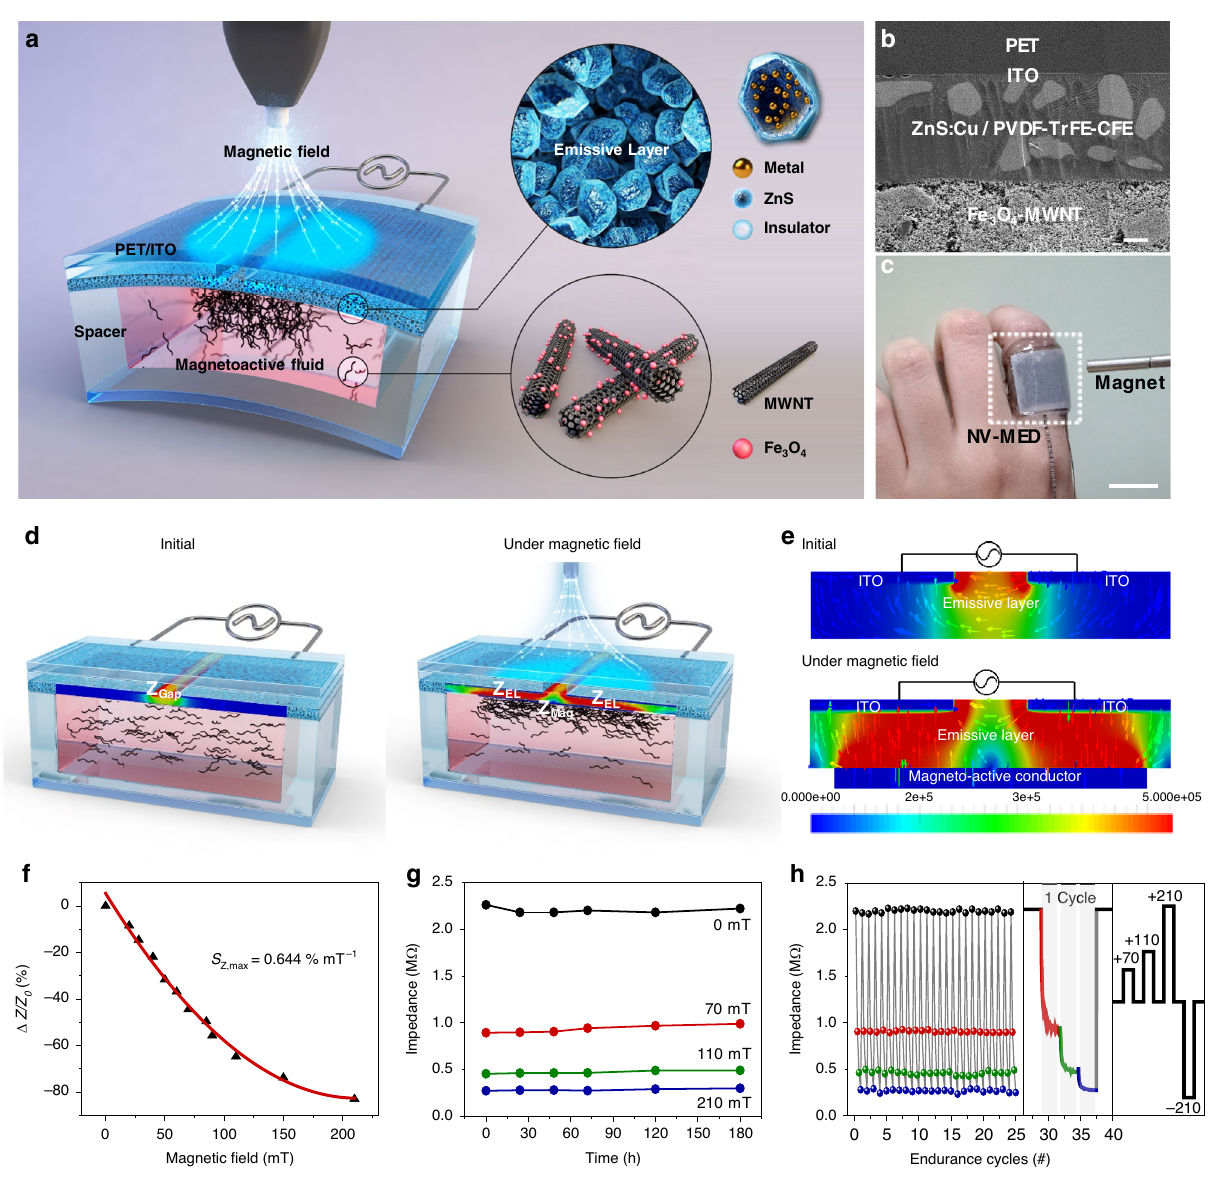
Fig. 1 Device architecture and working principle of NV-MED. a . Conceptual illustration of an NV-MED containing magnetoactive fl uid with two in-plane electrodes. A fl oating electrode is developed by the percolation network of magnetoactive fl uid. b . A cross-sectional SEM image of an NV-MED (scale bars: 1 μ m). c NV-MED mounted on the back of a hand (scale bars: 1 cm). d Schematic of the electrical circuit of an NV-MED in the reading process. e FEA of AC fi eld analysis of an NV-MED with distribution of electric fi eld magnitude on parallel-type electrodes upon reading and erasing, respectively. f Plots of the change in impedance intensity of an NV-MED as a function of magnetic fi eld. g Time-dependent retention of the impedance intensity arising from an NV-MED. h Write – erase cycle endurance in EL intensity changes of an NV-MED. Inset shows the EL intensity change in one cycle and scheme of four successive magnetic fi eld programmes for the endurance